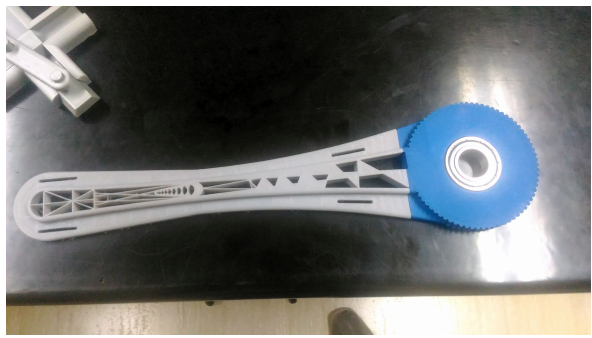
Figure 11: Two parts of the lower arm actuator printed using differ- ent materials